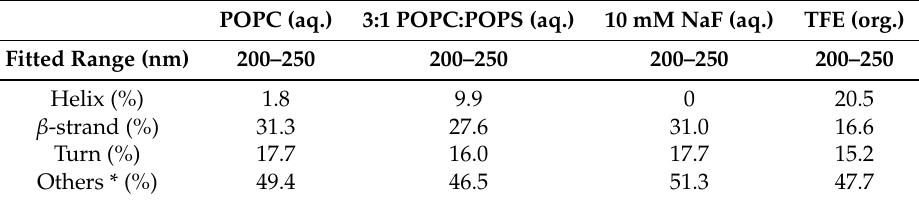
Figure 10. KEIF CD spectra recorded in presence of POPC and 3:1 POPC:POPS vesicles, in TRIS buffer supplemented with 10mM NaF. Lipid:KEIF molar ratio was 16:1. For comparison, spectra recorded in TRIS buffer supplemented with 10mM NaF and in TFE are also shown. Dashed lines represent BeStSel [5,6] fits. Table 7. Estimated secondary-structure content in KEIF, returned from BeStSel [5,6] fitting of CD spectra in Figure